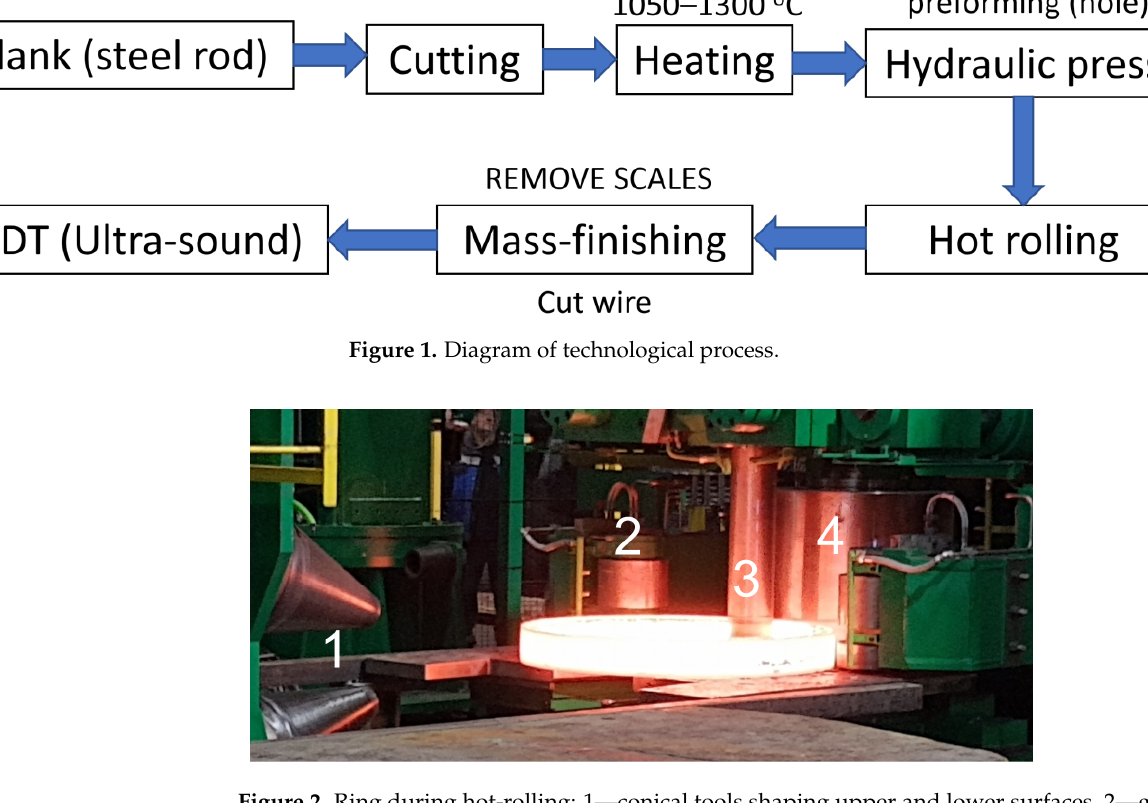
Figure 2. Ring during hot-rolling: 1—conical tools shaping upper and lower surfaces, 2—guiding roller, 3—internal roller and 4—external rollers.